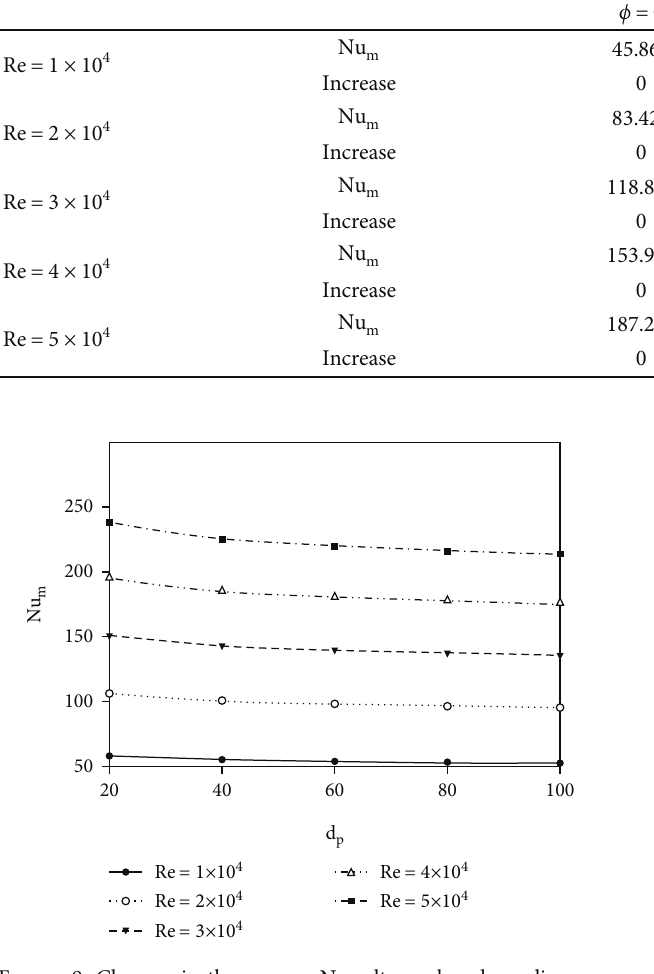
Figure 10: Variations of average skin friction coe ffi cient based on nanoparticle diameter ð ϕ = 0 : 04 Þ